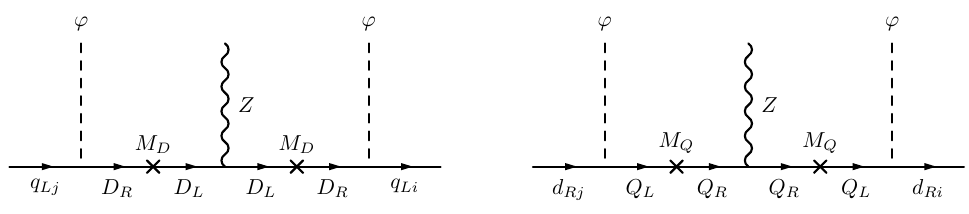
Figure 3 . Anomolous flavour non-diagonal couplings of Z -boson with SM families, contributing to flavour changing processes at tree